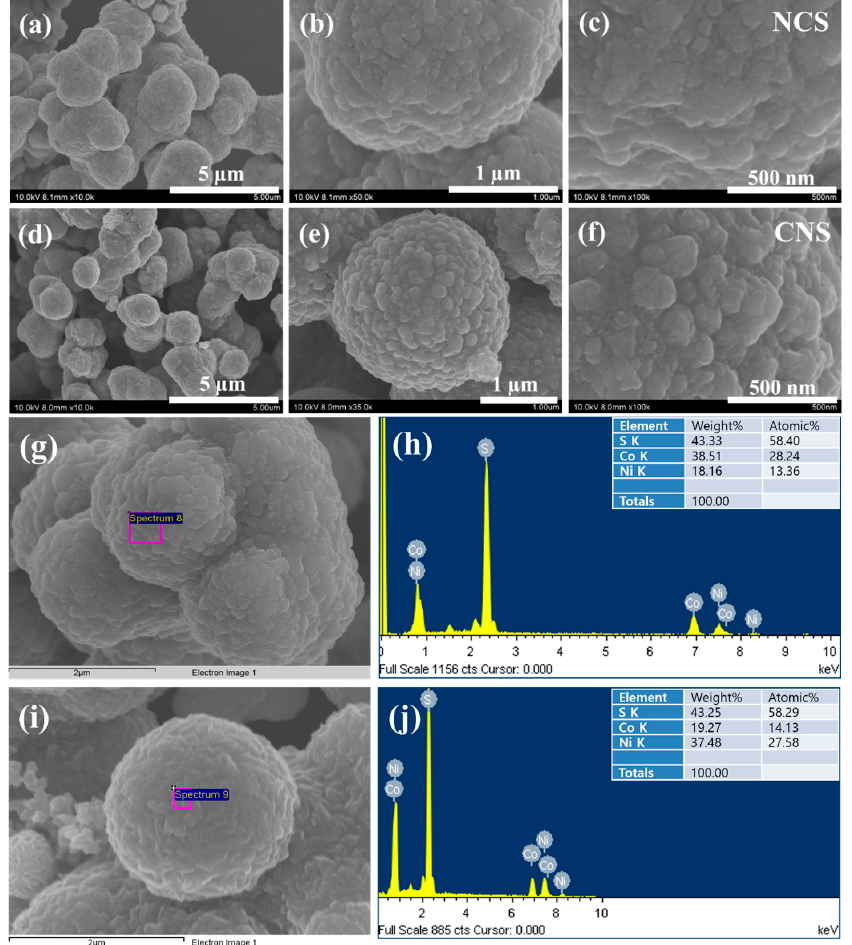
Figure 3. FE-SEM images of ( a – c ) NCS microspheres and ( d – f ) CNS microspheres. ( g , i ) Electron images of NCS and CNS samples, respectively. ( h , j ) EDX spectra of NCS and CNS,